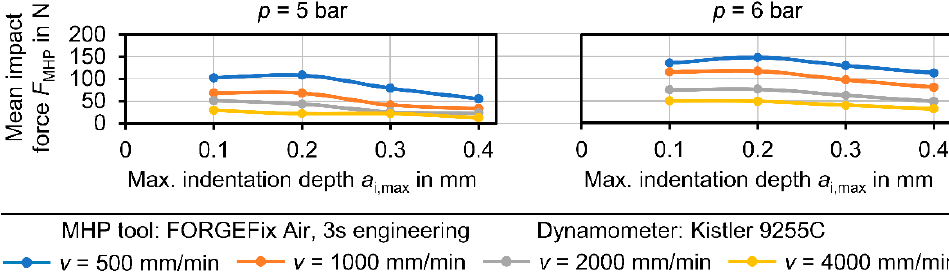
Figure 3. Maximal process forces during the Machine Hammer Peening